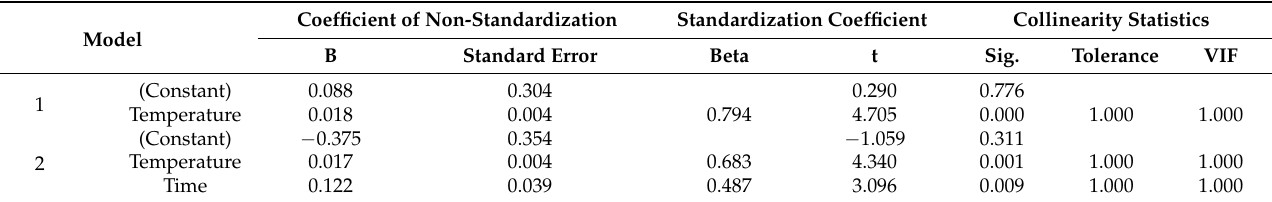
Table 7. The yield model coefficients of